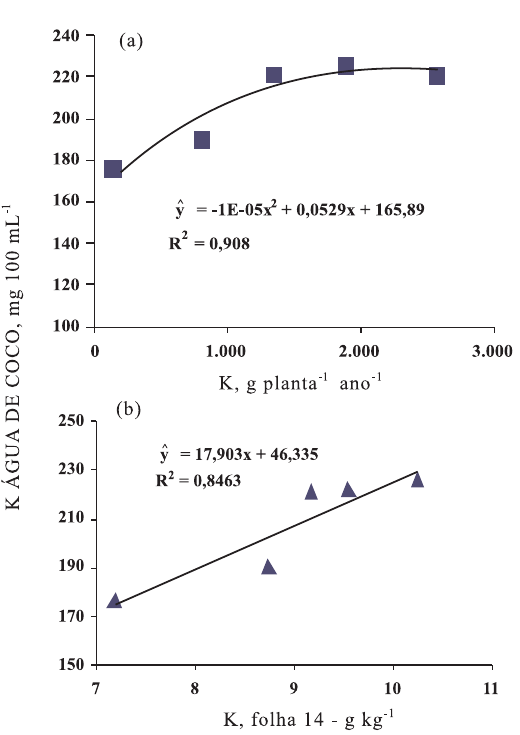
Figura 5. Teor de K na água do coco do coqueiro-anão verde em função do K aplicado (a) e do teor de K na folha